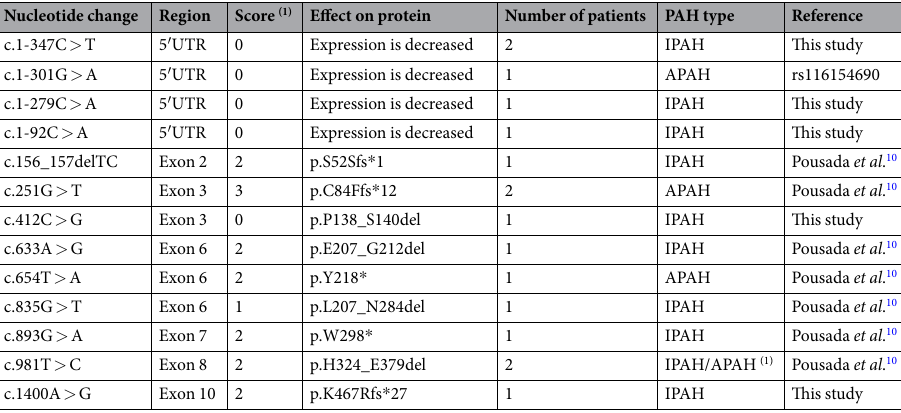
Table 4. Pathogenic mutations found in the BMPR2 gene in our clinical series. (1)This mutation appears in a patient with IPAH and in a patient with APAH.